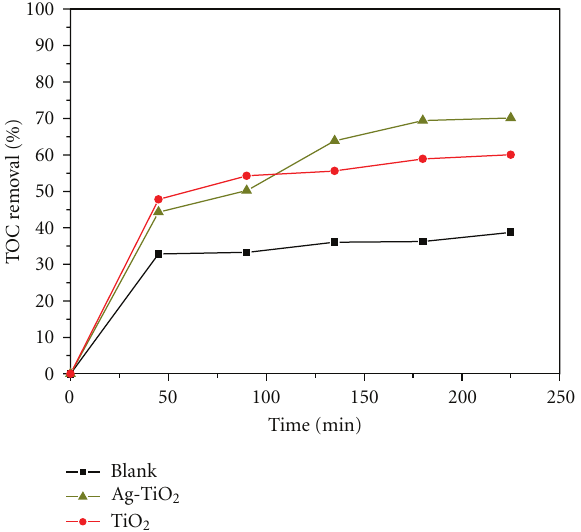
Figure 11: TOC removal percentage of E. coli versus adsorption time under dark by using TiO 2 and Ag-TiO 2 as